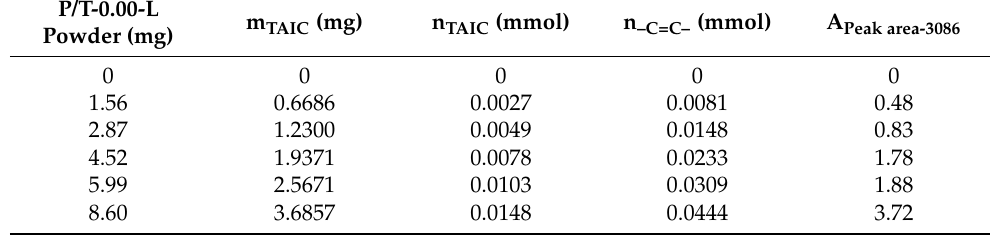
Table 3. Calculation of fitting data of different amounts of P/T-0.00-L sample powders.